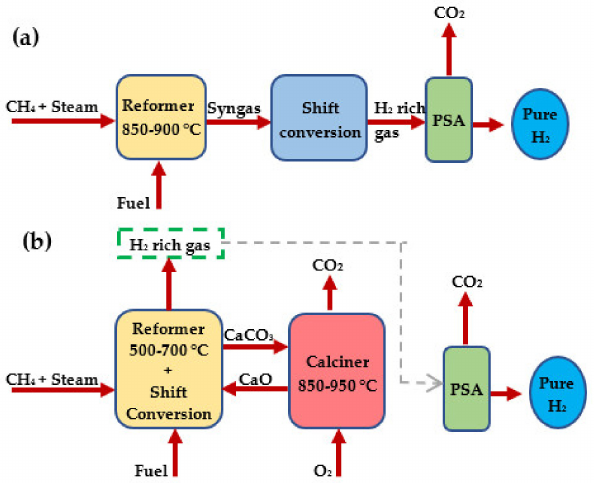
Figure 4. Flow diagram of ( a ) steam methane reforming and ( b ) sorption-enhanced steam methane reforming (CaCO 3 as